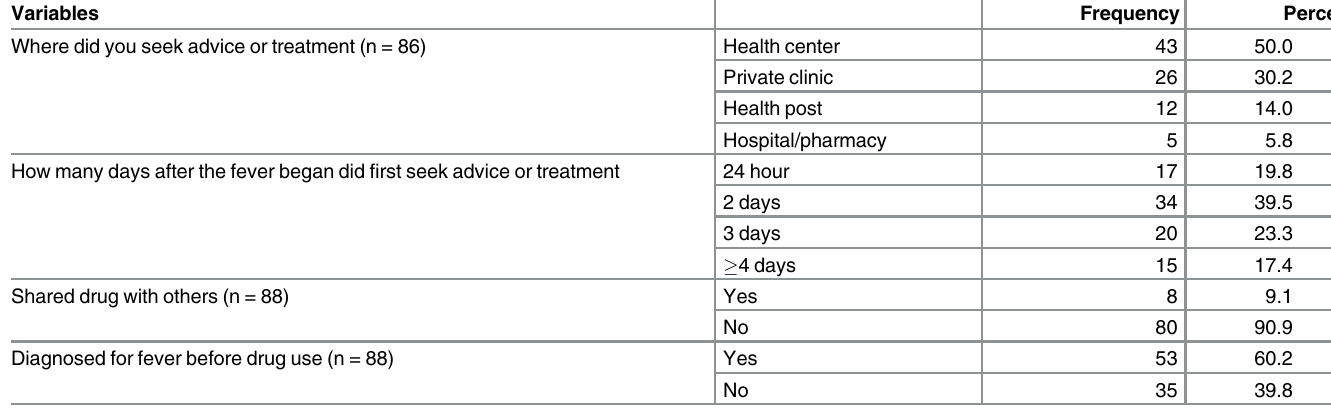
Table 4. Treatment seeking behavior after onset of fever among respondents, Jimma, Ethiopia (Jan 2014).